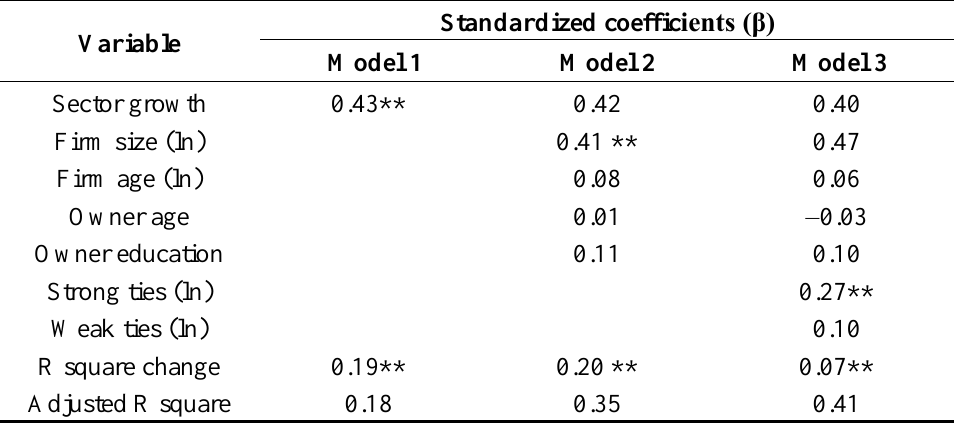
Table 3. Regression analysis of production expansion and network strength.